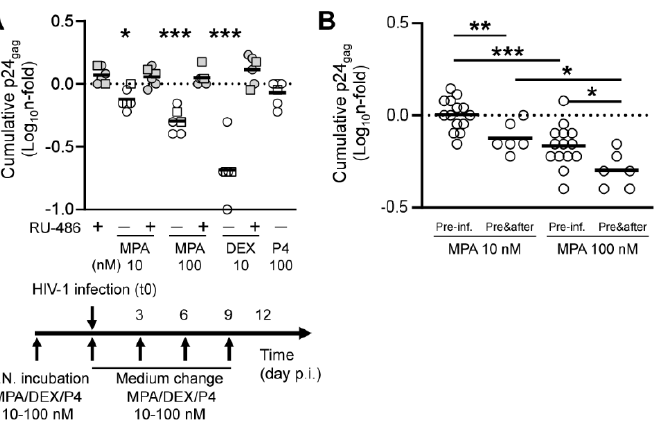
Figure 2. Virus production in tonsillar tissue explants treated with steroid hormones. ( A ) Virus production in tonsillar tissue explants treated with the same concentration of steroid hormones before and after HIV-1 infection (before and after). Tissue explants were incubated with medroxyproges- terone acetate (MPA), dexamethasone (DEX) and progesterone (P4) at the indicated concentrations, in the presence or the absence of mifepristone (RU-486) at 1 µ M, overnight upon dissection. Culture supernatant was replaced with fresh medium containing the same amount of compound used for explant pre-treatment, in the presence or the absence of RU-486 at 1 µ M, immediately before infection with HIV-1 BaL (squares, n = 2) and HIV-1 LAI (dots, n = 4). Explants were cultured using the same medium composition for 12 days with a change of medium every 3 days. The chart represents n-fold change in cumulative virus production (Day 6 to Day 12 post-infection) in supernatant of treated explants compared to donor-matched untreated explants (VEH). Lines indicate mean values. Asterisks denote a statistically significant difference with VEH (one sample t test,* p < 0.05, ** p < 0.01, *** p < 0.001). ( B ) N-fold change in cumulative virus production (Day 6 to Day 12 post-infection) in supernatant of explants treated with the indicated MPA concentration prior to infection (pre-inf., n = 14) or before and after infection (pre&after, n = 6) compared to donor-matched untreated explants (VEH). Lines indicate mean values. Asterisks denote a statistically significant difference between two groups ( t test,* p < 0.05, ** p < 0.01, *** p < 0.001). A pairwise comparison of MPA-treated groups between the two compound treatment setups (pre-infection vs before and after) demonstrated a statistically significant difference in the extent of HIV-1 reduction for both MPA 10 and 100 nM ( p = 0.0071 and p = 0.0260 respectively, n = 6–14) (Figure 2B). In summary, the magnitude of the effect of MPA treatment on HIV-1 production in lymphoid tissue depended not only on the administered dose prior to infection, but also on the length of treatment thereafter during